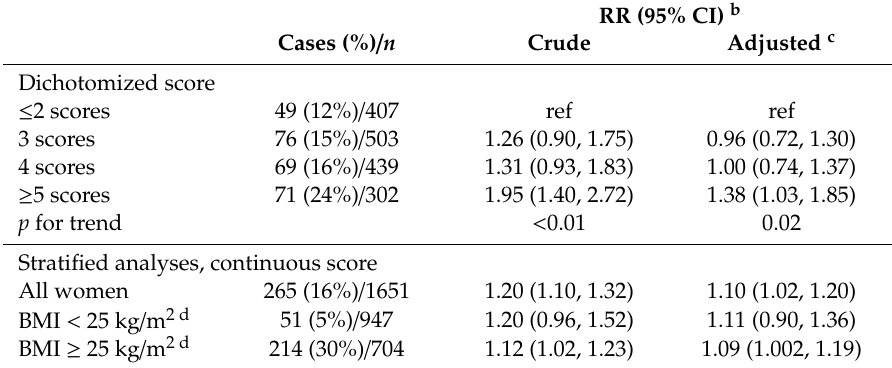
Table 3. The association between the dietary risk score and gestational diabetes a .